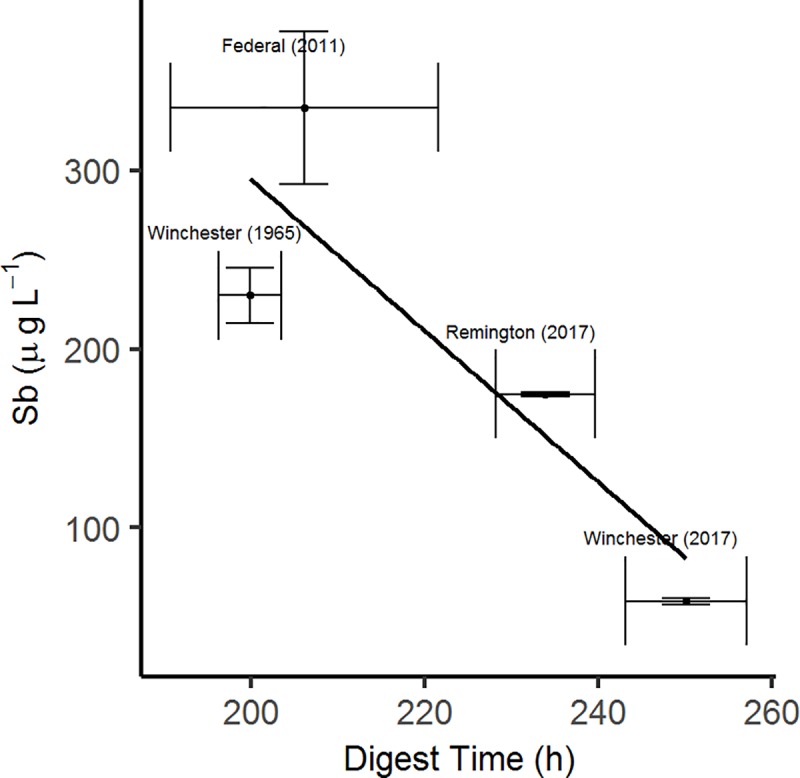
Average Sb concentrations of each Pb shot brand compared to average total digestion time.Among the four shot types tested, there was a general negative correlation (y = -4.2462x + 1144.9; r2 = 0.7514).